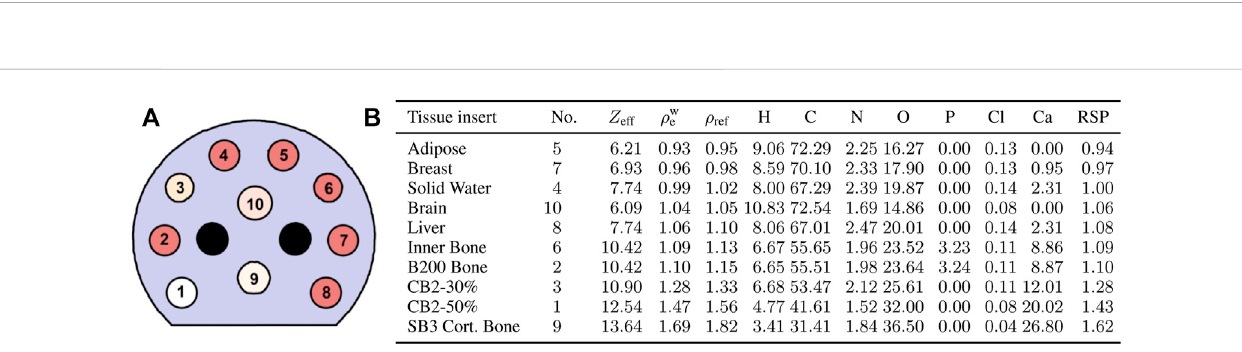
FIGURE 1 (A) Schematic of the experimental setup including a degrader wheel, micro-CT calibration phantom, and CMOS detector. A variable degrader like the depicted wheel is necessary at facilities with fi xed proton beam energies. (B) Detector signal corresponding to three different materials of the phantom at varying probing energies or degrader thicknesses (after 62.3 MeV initial energy), respectively.